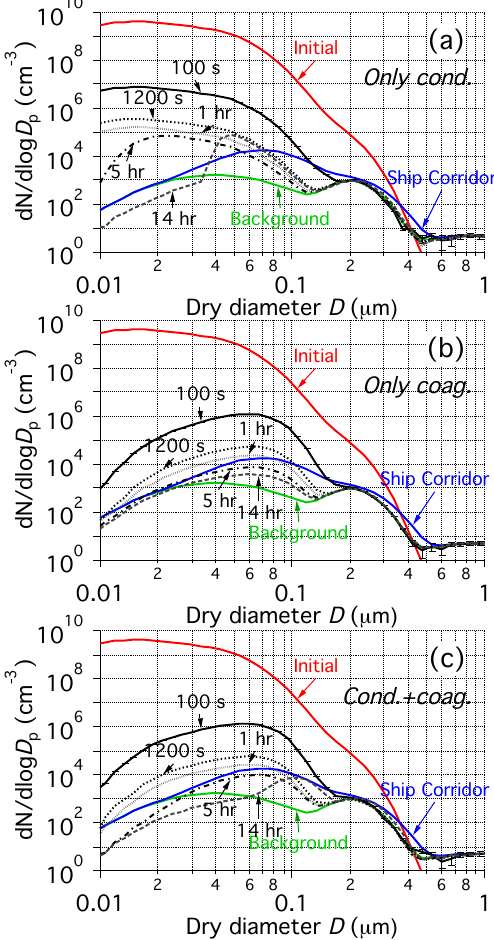
Figure 5. Measured aerosol number distributions for background, initial and ship corridor and modeled results for (a) neglecting coag- ulation, (b) neglecting condensation and (c) including condensation and coagulation at plume ages of 100s, 1200s, 1h, 5h, and 14h for sensitivity case (starting from 06:00LT). The error bars represent 95% confidence intervals from 10 ensemble runs (only shown for size distribution at 100s as an